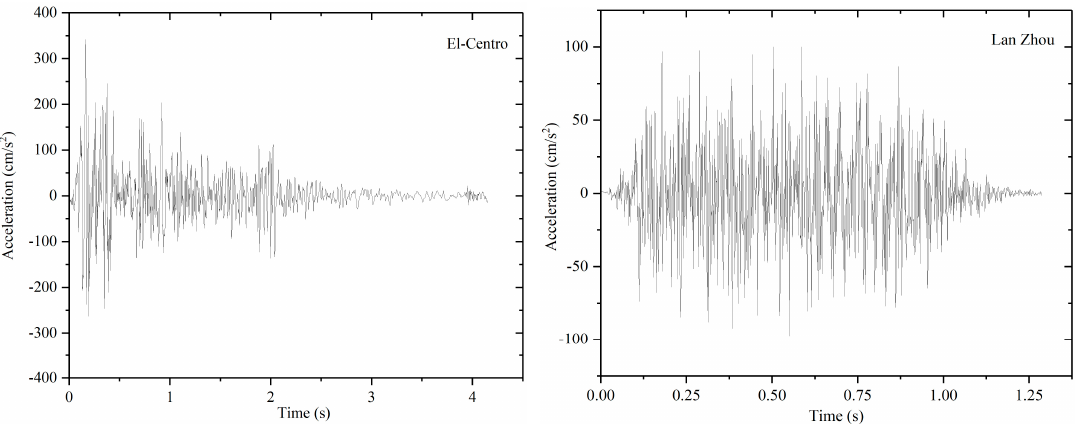
Figure 7. Time history of excitations. (El-Centro motion recorded at El Centro, USA, May 18, 1940. M7.1; Lanzhou motion: artificial earthquake wave.).